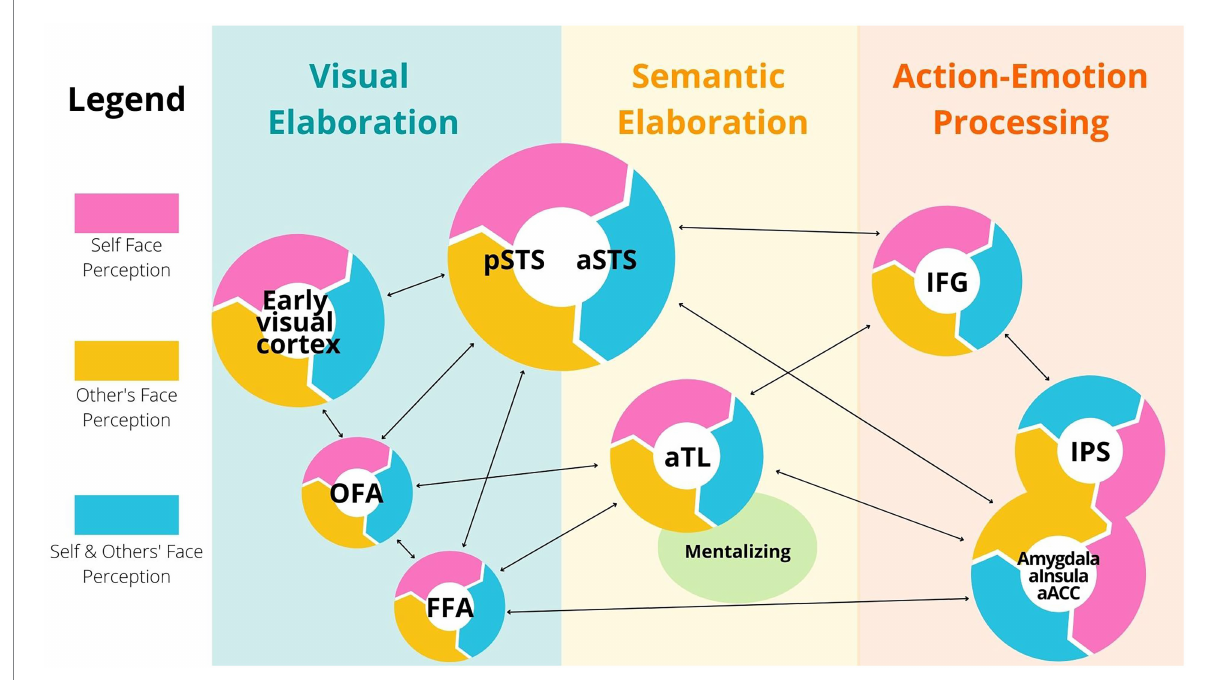
FIGURE 1 Simplified model of face selective areas. Different brain regions activate in a hierarchical and parallel fashion during perception of one’s own face and during perception of others’ faces. These regions are categorized by visual (light blue), semantic (light orange), action and emotion-centered elaboration (red). In this network, each region possesses both self-face perception areas (pink), others’ face perception areas (yellow) and areas that activate in both conditions (blue). These distinctions are meant to reflect probabilistic activations during task performances, and not domain- specific functions of the brain. Abbreviations: OFA: Occipital Face Area, FFA: Face Fusiform Area, pSTS and aSTS: posterior and anterior Superior Temporal Sulcus respectively, aTL: anterior Temporal Lobule, IFG: Inferior Frontal Gyrus, IPS: Inferior Parietal Sulcus, aInsula: anterior Insula, ACC: Anterior Cingulate